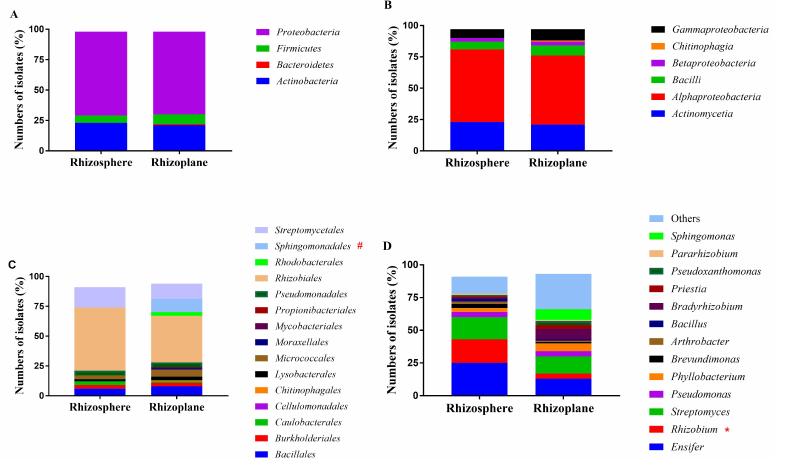
Figure 1. The taxonomic distribution of bacterial isolates, obtained from the rhizosphere and rhi- zoplane of C. medica , shown on Phylum ( A ), Class ( B ), Order ( C ), and Genera ( D ) level. Items labeled with * are taxa exhibiting significantly higher prevalence in the rhizosphere compared with the rhizoplane, while items with # are those with higher prevalence in the rhizoplane compared with the rhizosphere (Fisher’s exact test, p < 0.05).